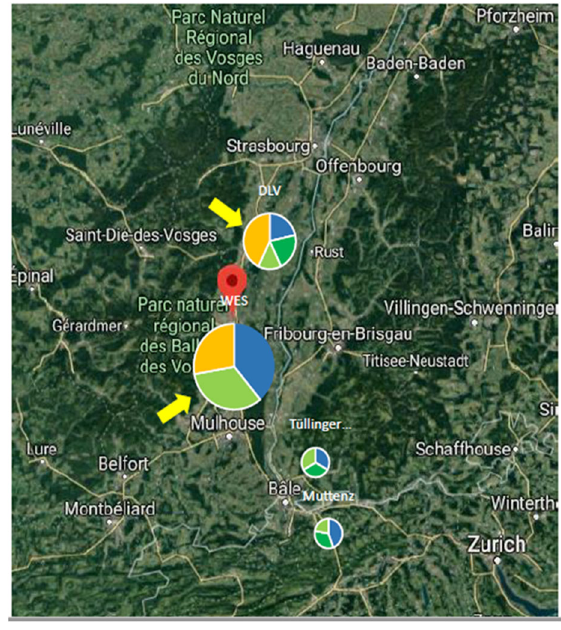
Fig. 2 The 49 vineyard plots involved in the Vine health trinational project. The number of vine plots involved in the trinational project on wine health are represented at scale with 19, 14, 8, and 8 plots in Westhalten (WES, France), Dambach La Ville (France), Tullinger Berg (TUL, Germany), and Muttenz (MUT, Switzerland), respectively. Blue, dark green, and light green represent conventional, organic, and biodynamic practices, respectively. In Westhalten and Dambach La Ville, pictures resembled those at Muttenz and Tullinger Berg, at the beginning of the project with 13 plots in Westhalten and nine in Dambach la Ville. As a result of the participatory action research, the number of vine plots increased to 33 in these two places and some winegrowers shifted from conventional to either organic, biodynamic, or 100% biocontrol practices in 2018 – 2019, as illustrated in